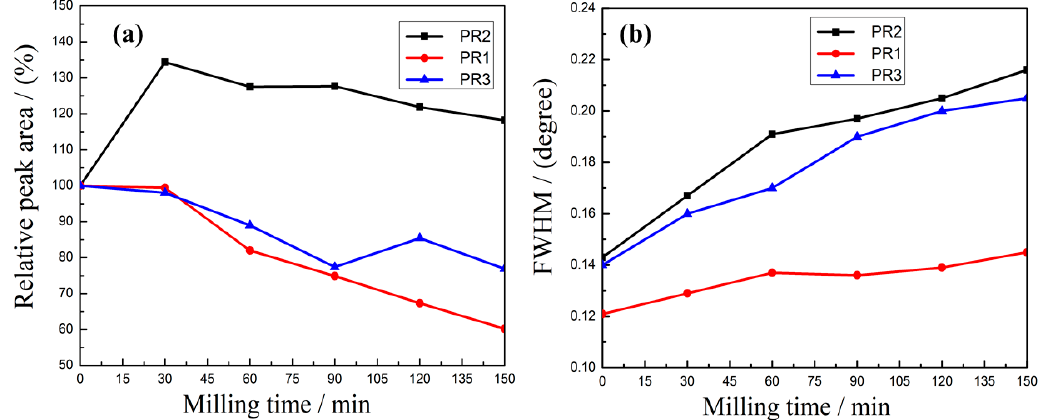
Figure 3. Relative peak areas ( a ) and half-widths ( b ) of three PR powders at different milling